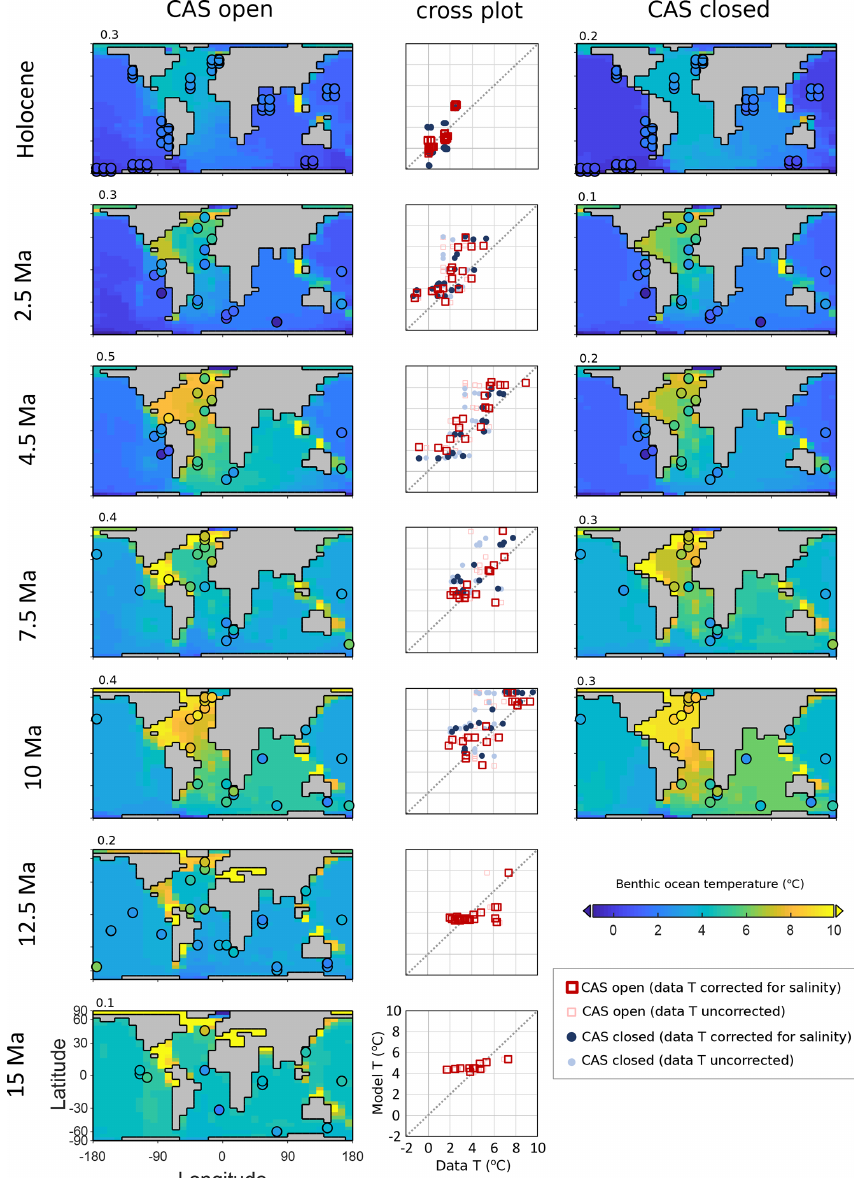
Figure 10. Benthic temperature for the best fit model settings, with data overlaid as shaded circles, and cross plots of data points ( x axis) and model points ( y axis), with temperature calculated with no salinity correction (semi-transparent) and with salinity correction (opaque). Noted above each map is the FwF setting (in Sv). The model–data fit statistic (M-score) is shown in Fig.